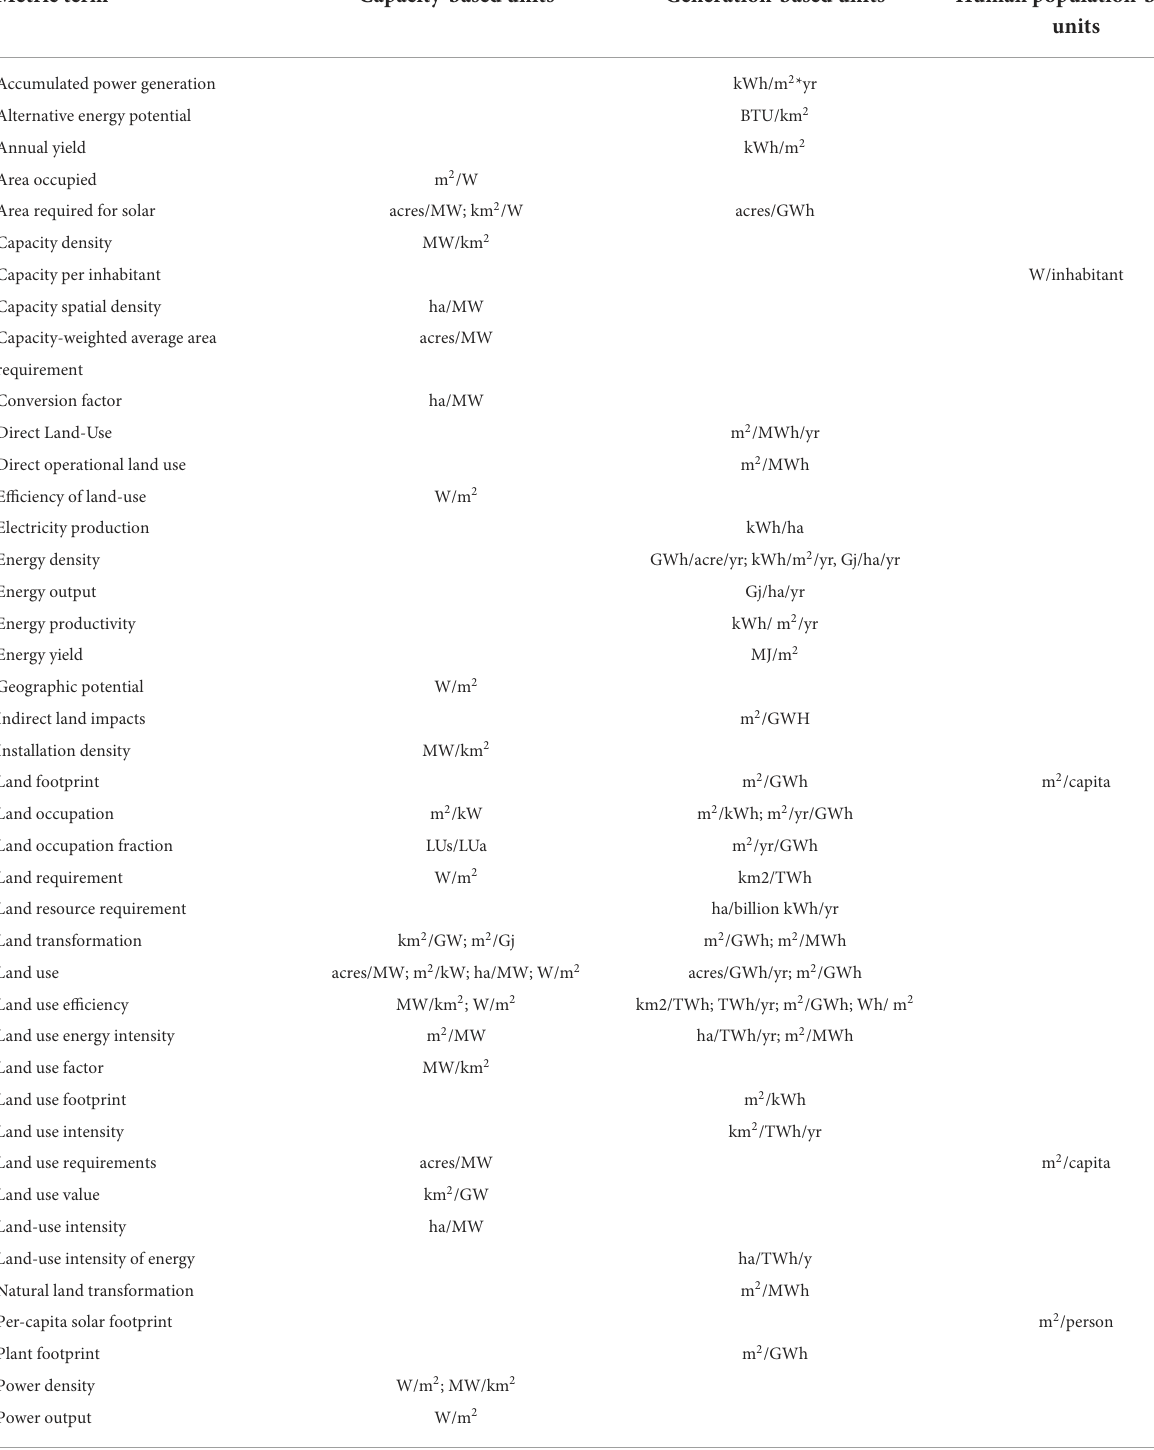
TABLE 3 Classification of units of measure for all solar energy-land metric terms. Metric term Capacity-based units Generation-based units Human population-based